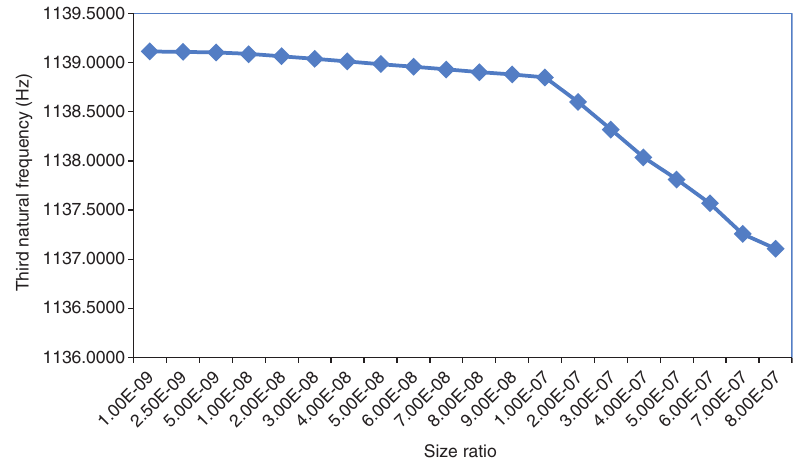
Figure 15: Variations of the third natural frequency of the cantilever beam with size ratio.